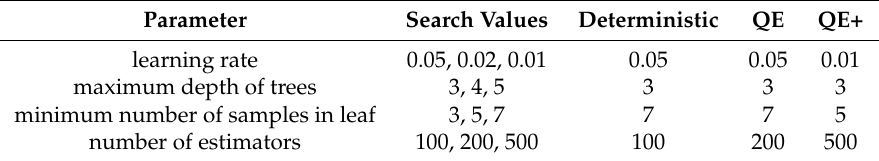
Table 2. Algorithm parameters tuned with grid search and 3-fold cross-validation.